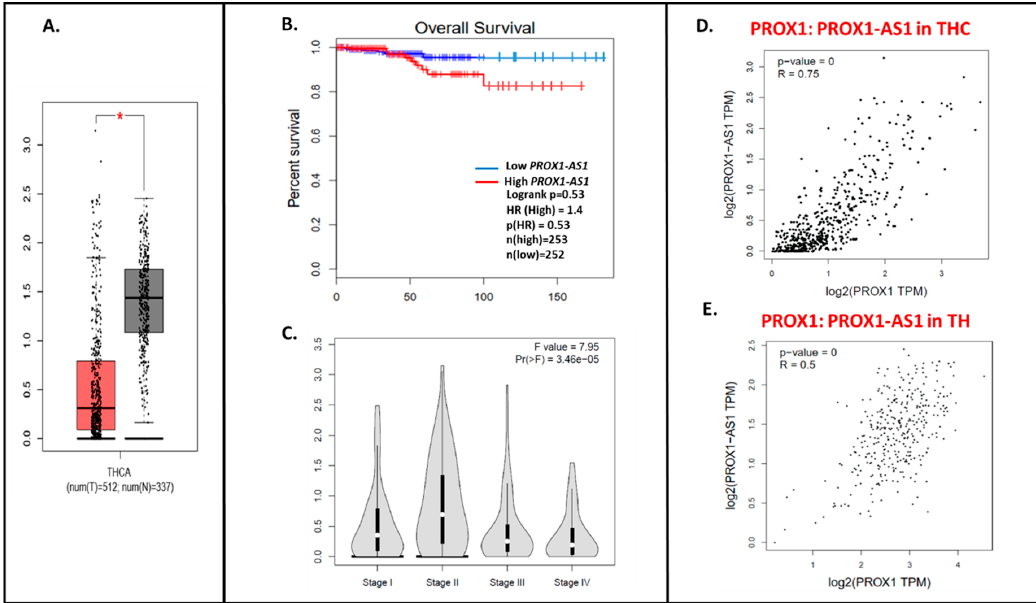
Figure 5. The PROX1-AS1 expression pattern in thyroid cancer and correlation with PROX1 . ( A ) Expression of PROX1-AS1 in thyroid cancer specimens (pictured on the red bar (T); the number of cases = 512) compared to non-cancerogenic thyroid tissues (pictured on the grey bar (N); the number of cases = 337), * p ≤ 0.05. ( B ) PROX1-AS1 relation to survival of patients with THC. ( C ) PROX1-AS1 expression compared to tumor stage I, II, III, and IV. ( D , E ) PROX1-AS1 : PROX1 correlation in THC and healthy thyroid (TH) specimens, respectively.